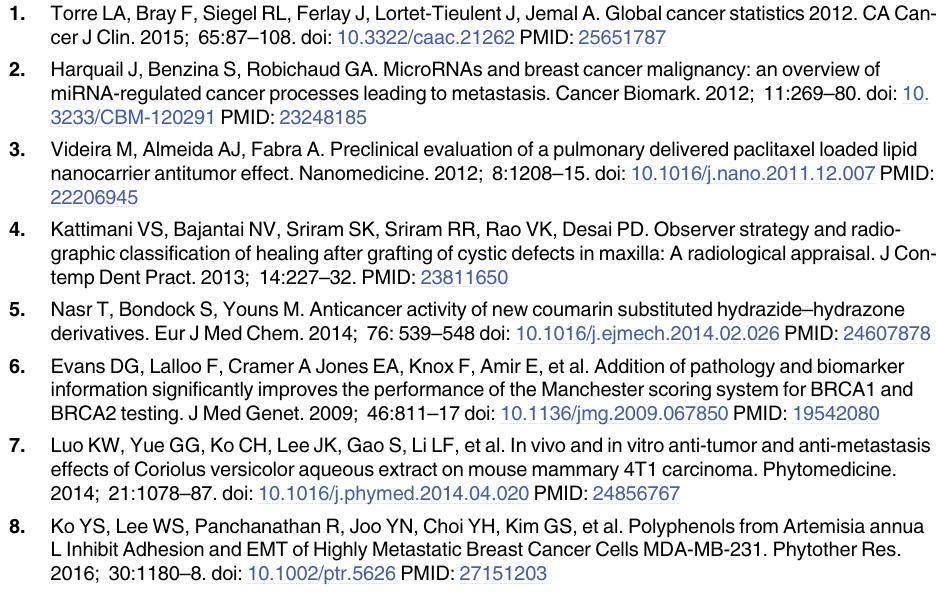
S4 Table. Procheck statistics of 3D structure human Ahr PAS-B domain.